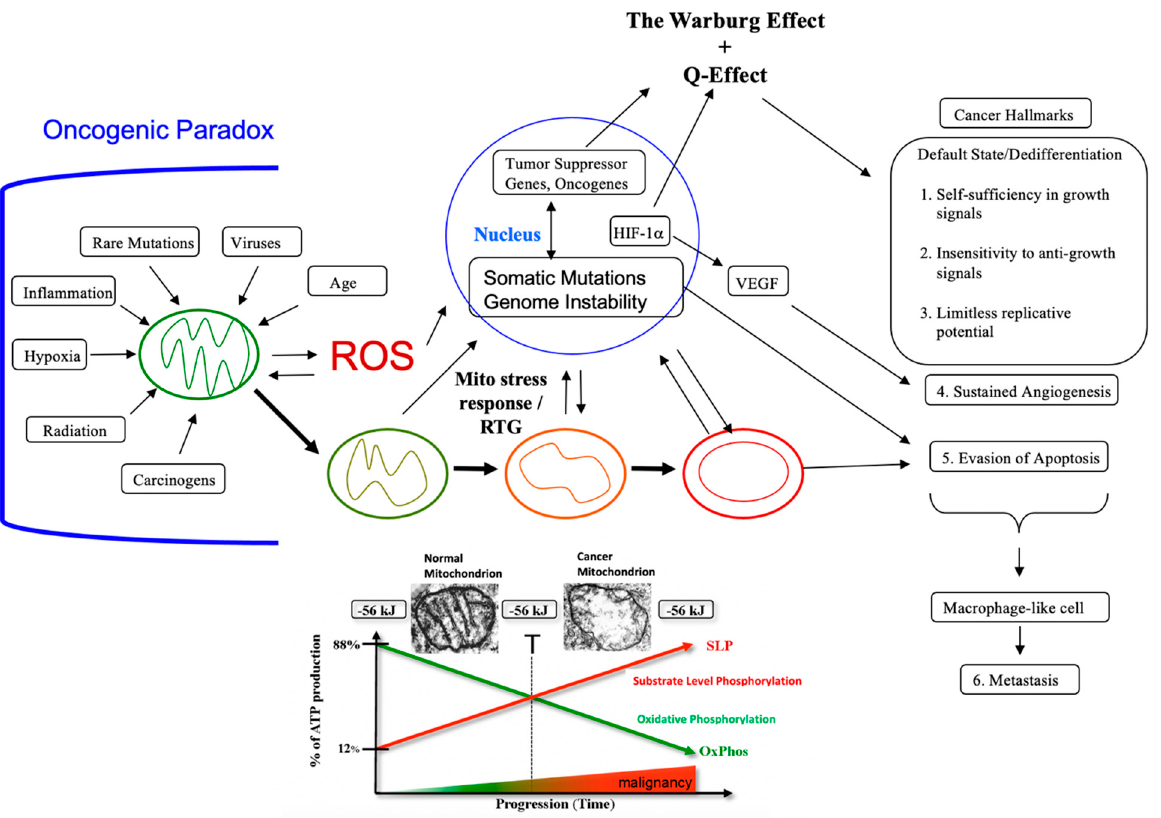
Figure 2. Cancer as a Mitochondrial Metabolic Disease. Cancer can arise from any number of unspecific influences (risk factors) that would alter the number, structure, and function of mitochondria thus affecting energy production through OxPhos. Unspecific cancer risk factors can include, age, viral infections, the Ras oncogene, rare inherited mutations, chronic inflammation, intermittent hypoxia, radiation exposure, chemical carcinogens etc. [2,65–68]. Any of these risk factors could cause chronic damage to OxPhos thus increasing the production of reactive oxygen species (ROS), which would